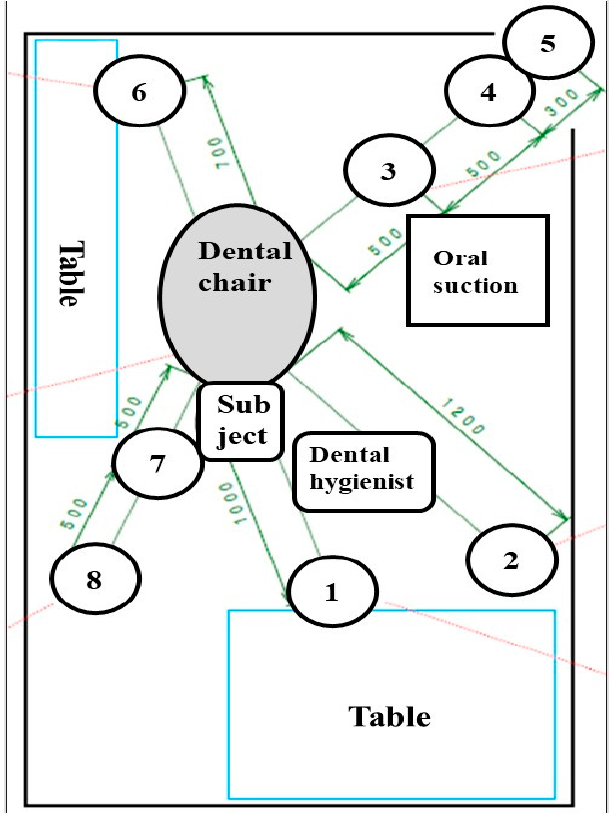
Figure 1. Sampling areas of droplets and aerosols for detection of bacterial numbers. Numbers (1~8) indicate the location of BHI agar and R2A agar plates that were placed radially from the dental chair at 1-m intervals.